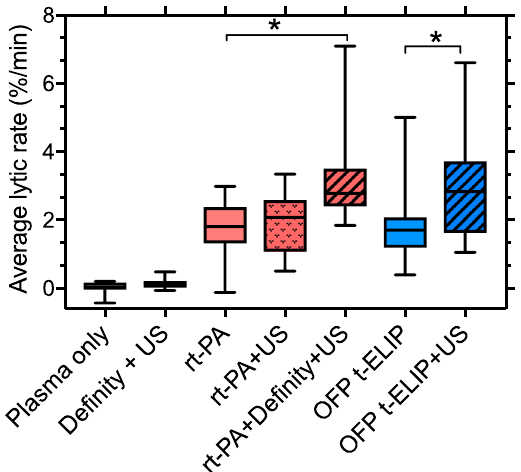
Figure 6. Average lytic rate obtained with clots exposed to plasma alone, rt-PA, rt-PA + US, rt-PA + Definity + US, and rt-PA + Definity + US. For each group, n = 16 clots were tested. The error bars represent ± 1 standard deviation. Differences ( p < 0.05) across treatments are denoted by ( *